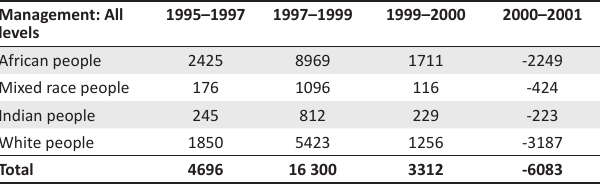
TABLE 2: Net change in female managers – All levels: 1995–2001.